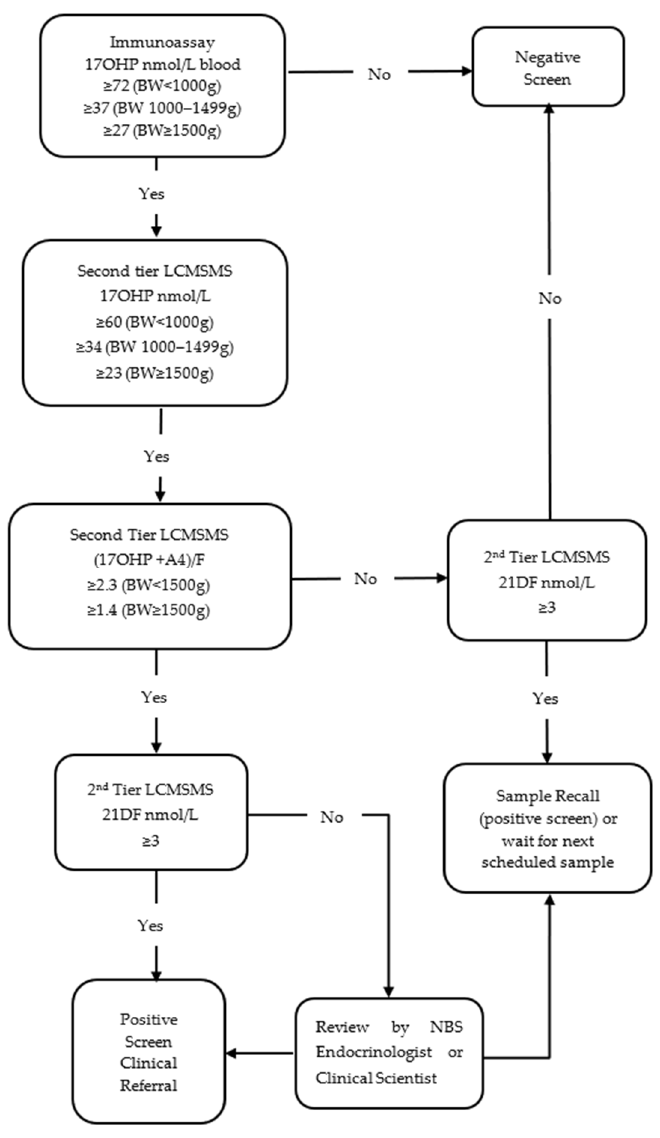
Figure 2. Flowchart of a new laboratory protocol (Protocol 2) for NBS for congenital adrenal hyper- plasia in New Zealand .